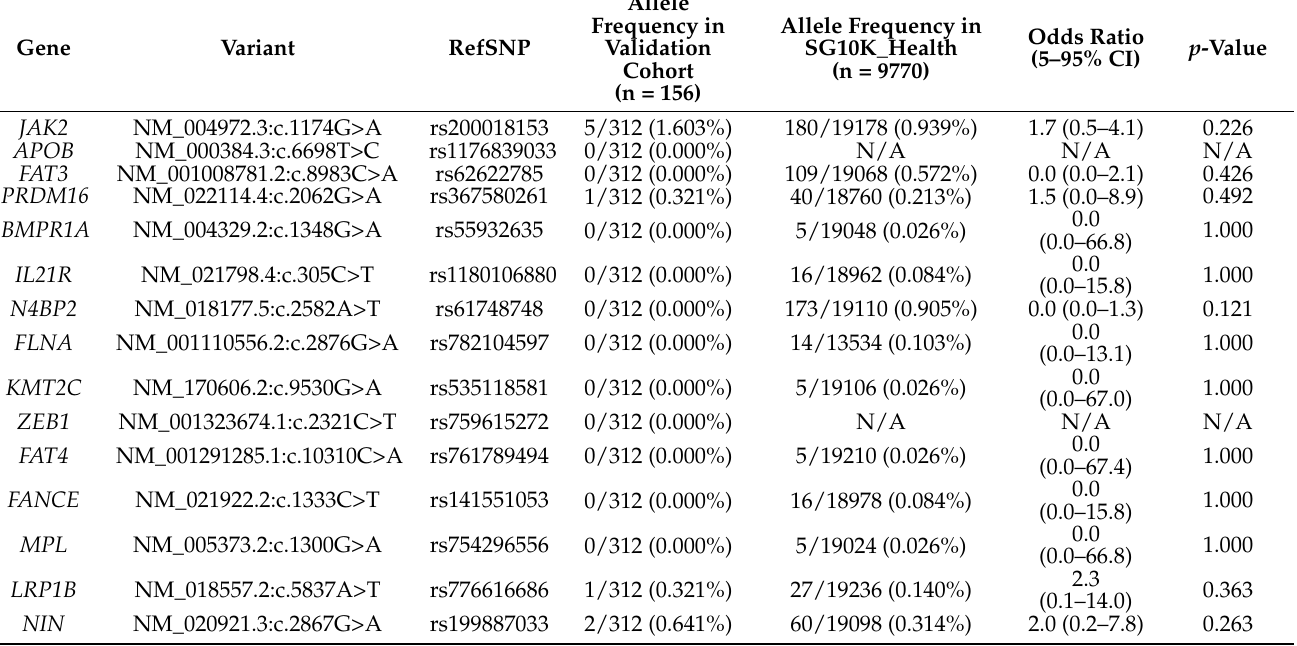
Table 2. Allele frequencies and case-control association analysis of 17 selected variants in the valida- tion